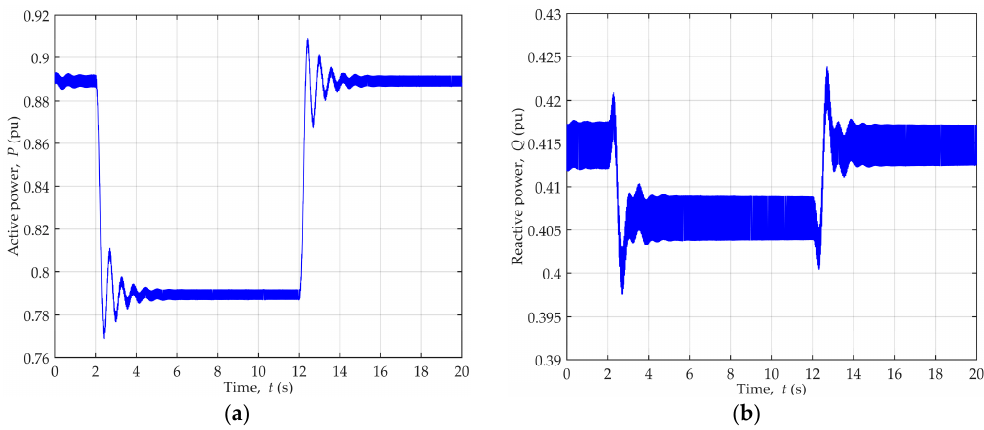
Figure 14. Generator power change during dynamic disturbances of active power for generator operating point P = 0.89, Q = 0.41 ind.: ( a ) Active power; ( b ) Reactive power.